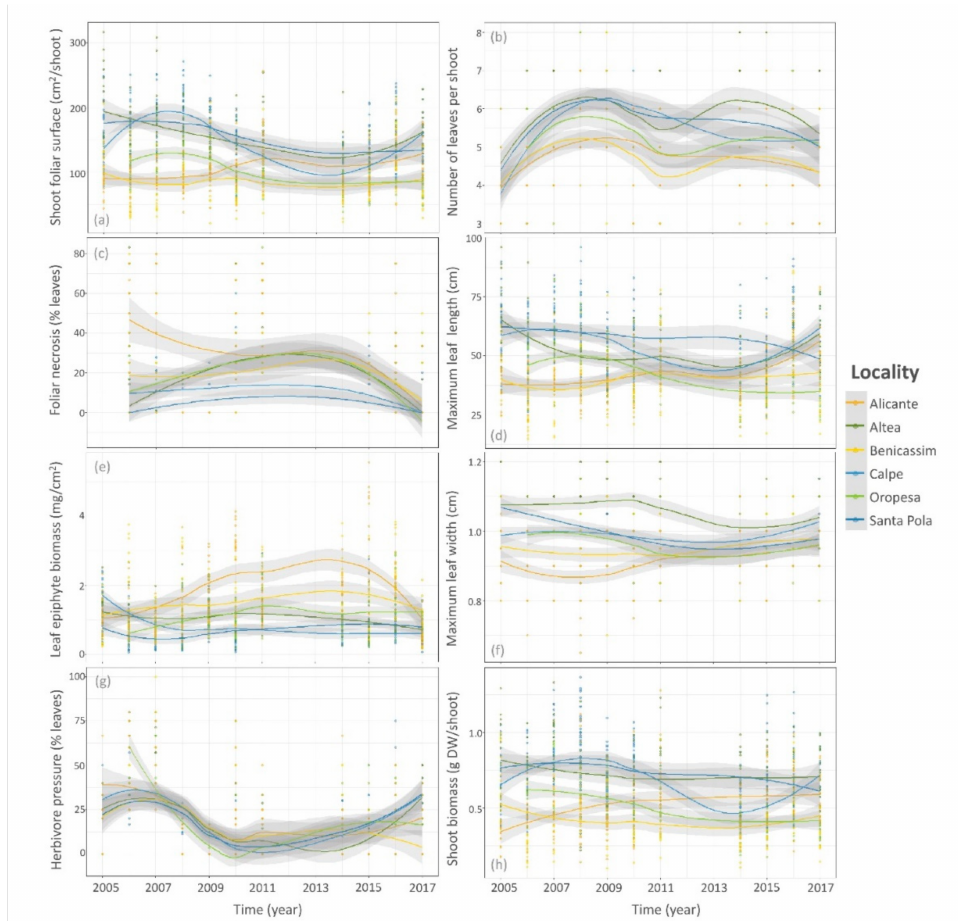
Figure 5. Temporal trends in ( a ) Shoot foliar surface, ( b ) Number of leaves per shoot, ( c ) Foliar necrosis, ( d ) Maximum leaf length, ( e ) Leaf epiphyte biomass, ( f ) Maximum leaf width, ( g ) Herbivore pressure and, ( h ) Shoot biomass. Di ff erent colors indicate di ff erent locality and meadows conservation status (bluish = high, greenish = good, yellow-orange = poor). The shaded bands surrounding the estimated trends represent 95% confidence